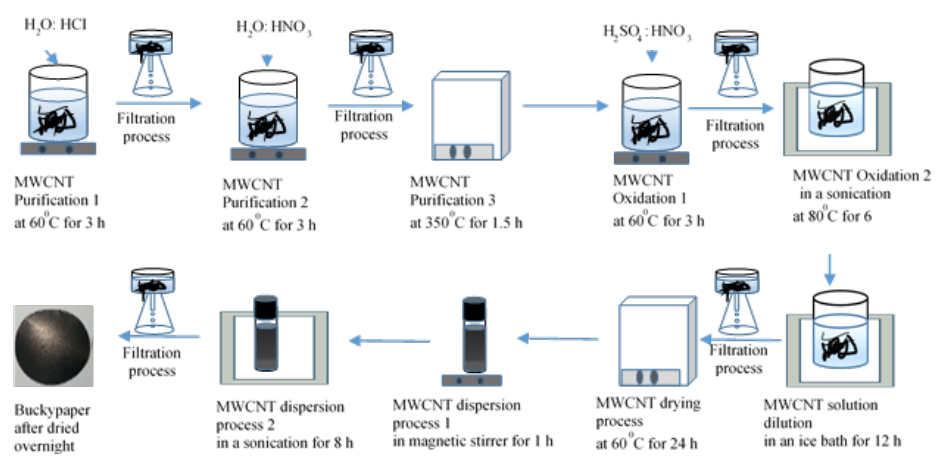
Figure 1. Schematic diagram of the unheated buckypaper preparation.